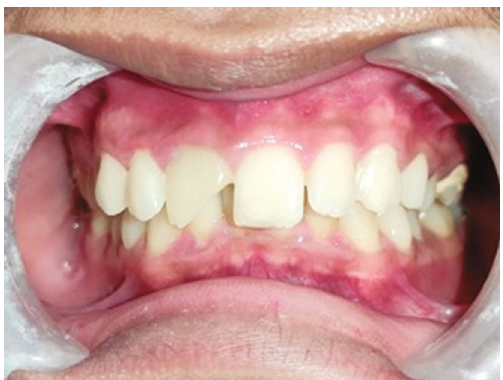
Figure 2: Clinical features. Intraoral photography highlighting #11 with class III Ellis crown fracture classi fi